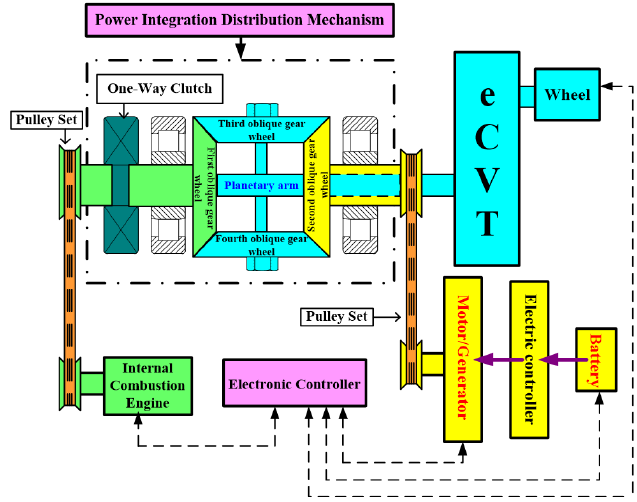
Figure 1. Schematic of the parallel hybrid power system.